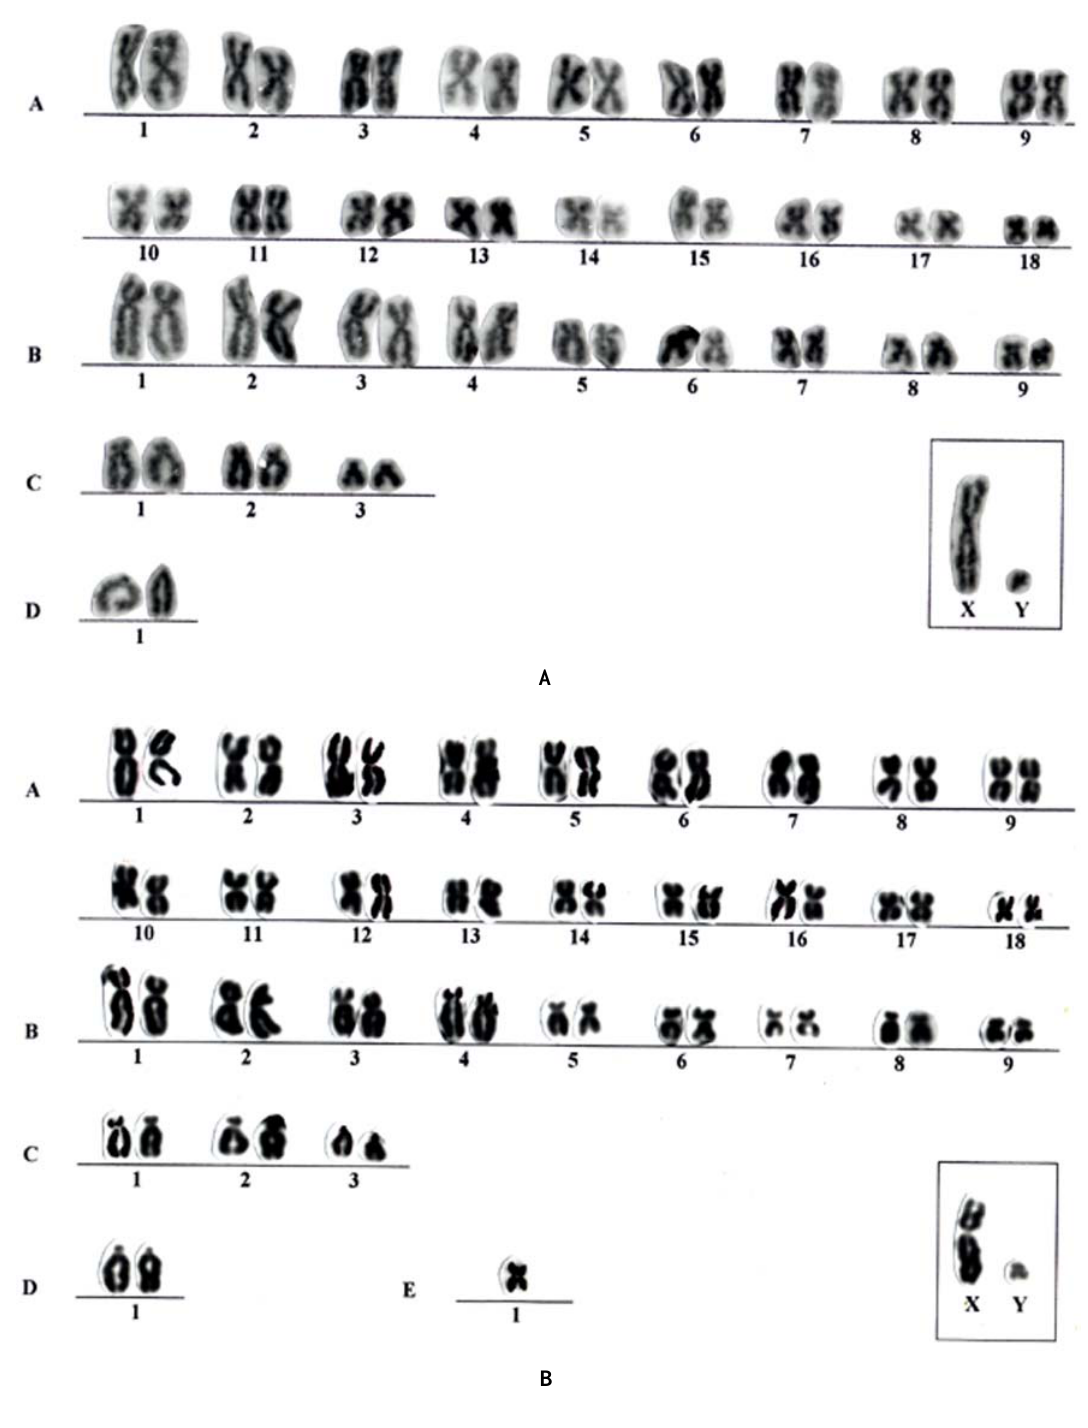
Fig. 3 – Karyotypes of the lineages 2n=64 and 2n=65 (lymphocytes culture) from a male sample (N=283) of Dasyprocta sp. in conventional Giemsa stain. A) lineage 2n=64; B) lineage 2n=65.